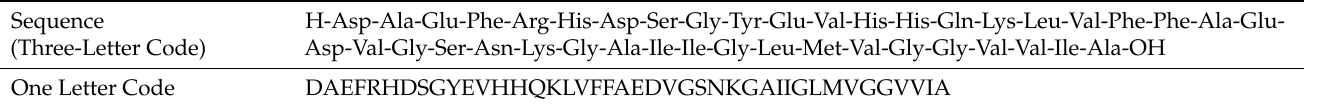
Table 2. Detail information of β -Amyloid